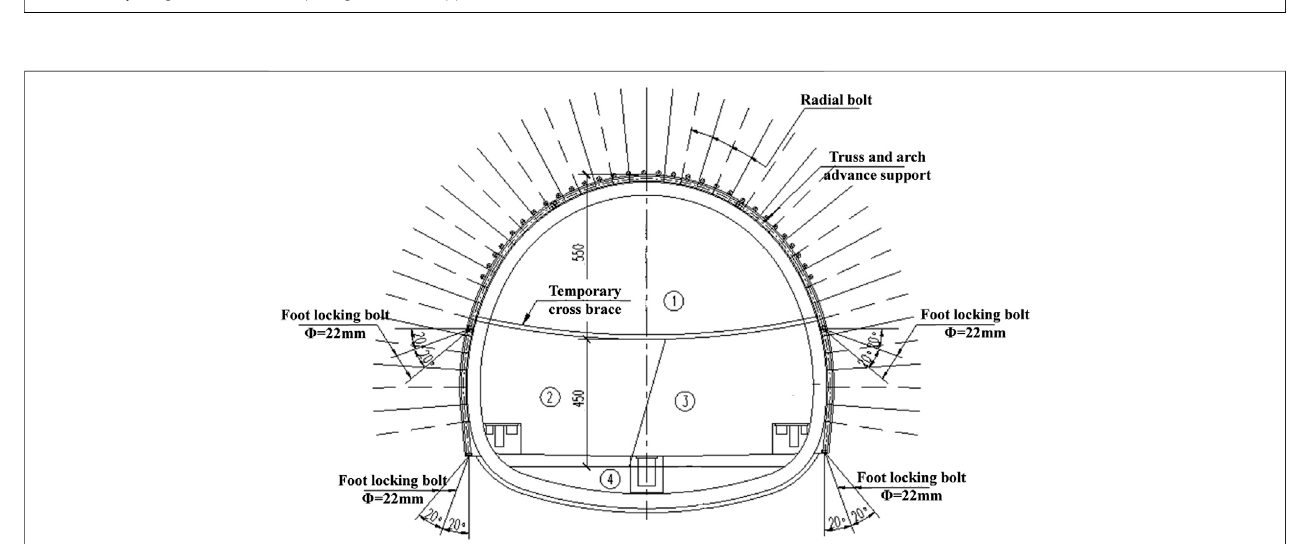
FIGURE 3 | Construction process of a double-track tunnel step method with temporary transverse